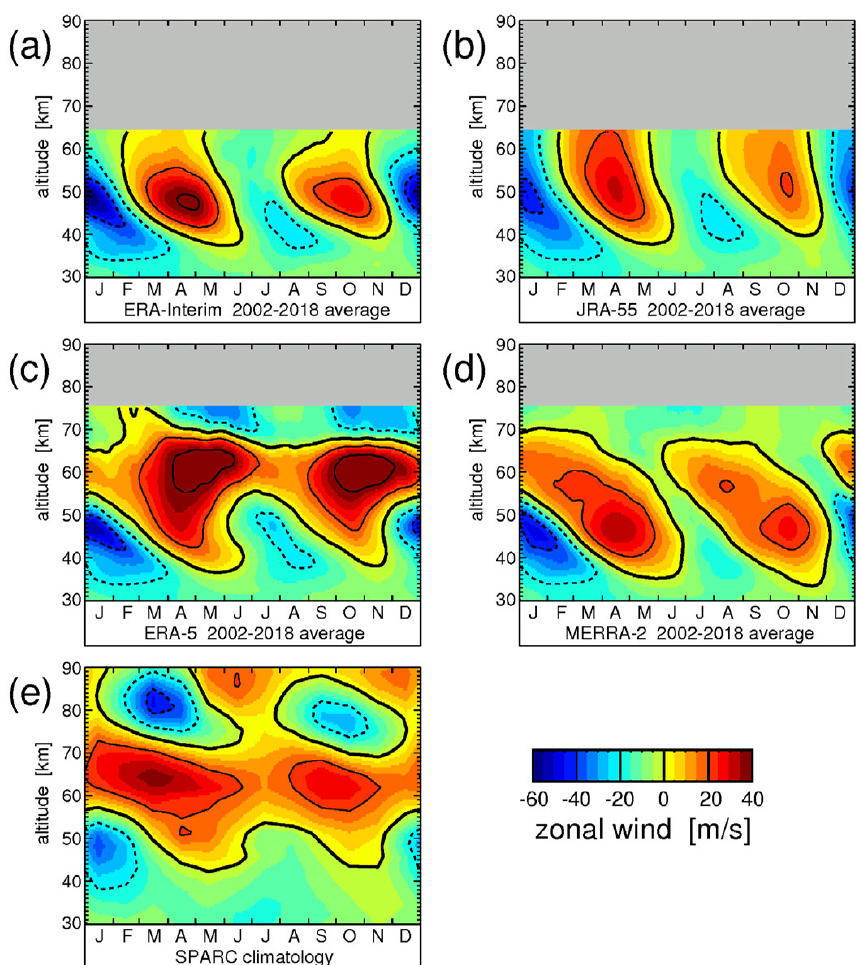
Figure 2. Typical seasonal variation of the zonal-average zonal wind averaged over 10 ◦ S–10 ◦ N and the time period 2002–2018 for the four reanalyses (a) ERA-Interim, (b) JRA-55, (c) ERA-5, and (d) MERRA-2. For comparison, (e) shows the corresponding zonal winds of the SPARC climatology (see Swinbank and Ortland, 2003; Randel et al., 2002, 2004). Overlaid are contour lines of the respective wind data set. Contour line increment is 20ms − 1 . The zero wind line is highlighted in bold solid contour lines, and westward (eastward) winds are indicated by dashed (solid) contour